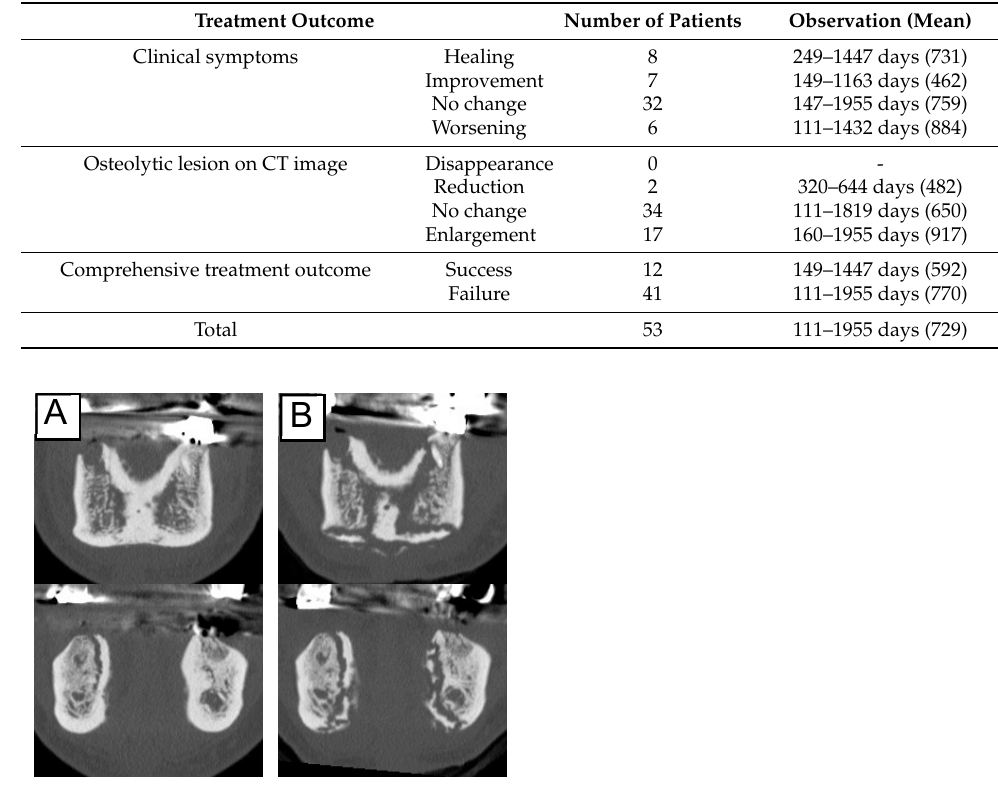
Figure 2. Changes in the imaging findings. The extent of osteolysis increased despite improved clinical findings: ( A ) before treatment; ( B ) nine months